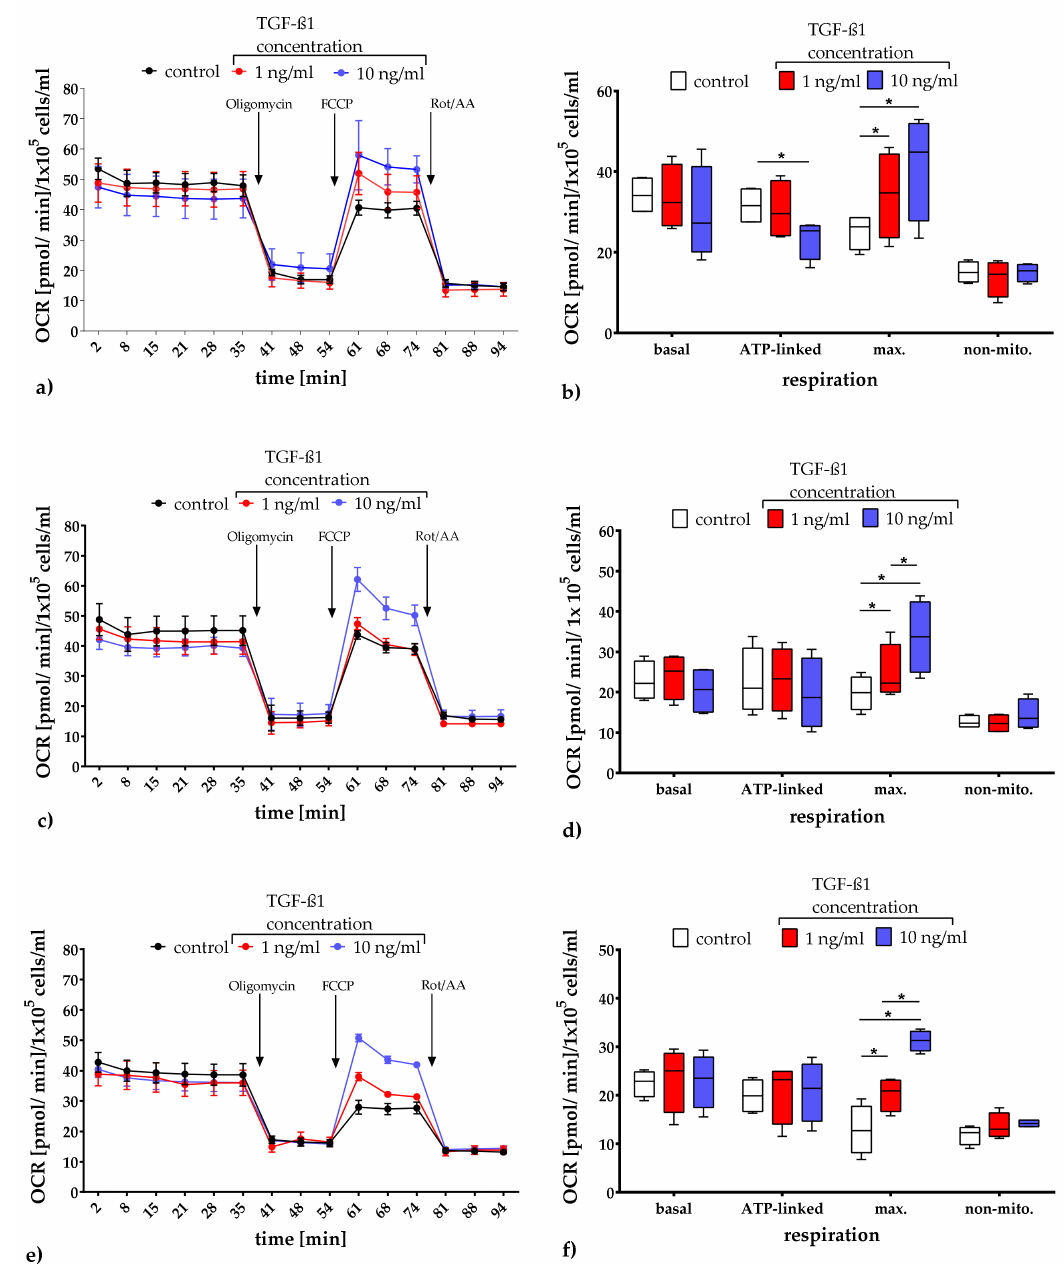
Figure A2. Quantification of the oxygen consumption rate (OCR) after TGF-ß1 exposure on days 1 (a, b), 3 (c, d), and 7 (e, f). OCR data presented as mean with the standard error of the mean normalized to 1 x 10 5 cells / ml (a, c, e). Corresponding to their function in the respiratory chain, the numerical data were presented as box plots, with medians, interquartile ranges, and minimum / maximum values (b, d, f). Since the dataset did not represent a Gaussian distribution (Shapiro-Wilk test), the statistical analysis was performed using the Two-Way ANOVA test followed by Tukey’s multiple comparison post hoc test ( n = 4). *, p -value ≤ 0.05. Comparison with the control. FCCP: carbonyl-cyanide-4 (trifluoromethoxy) phenylhydrazone; Rot / AA: rotenone / antimycin A; ATP: adenosine triphosphate; max.: maximal; non-mito.: